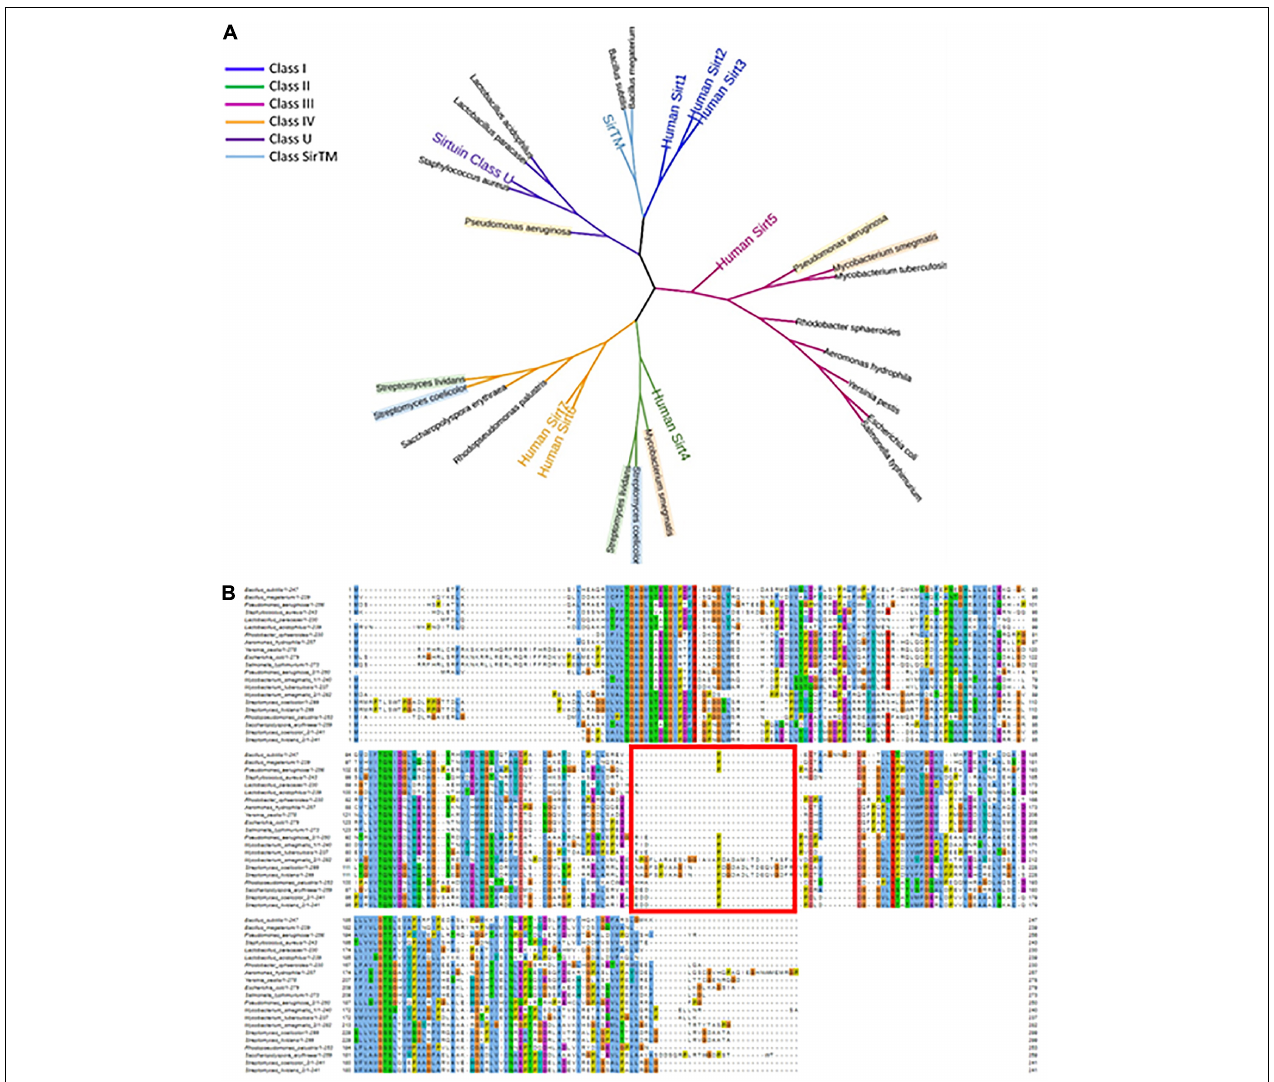
FIGURE 3 | Phylogenetic tree and MSA of the sirtuins covered in this work. (A) Sirtuins are shown labeled with the name of their host species. Those species holding two sirtuins are labeled with a background color. The tree includes all human sirtuins and one representative of sirtuins class U and class TM for class identification. Branch colors indicate the sirtuins class. (B) Mafft multiple sequence alignment of the 21 sirtuins covered in this work. A red square indicates the loop insertion